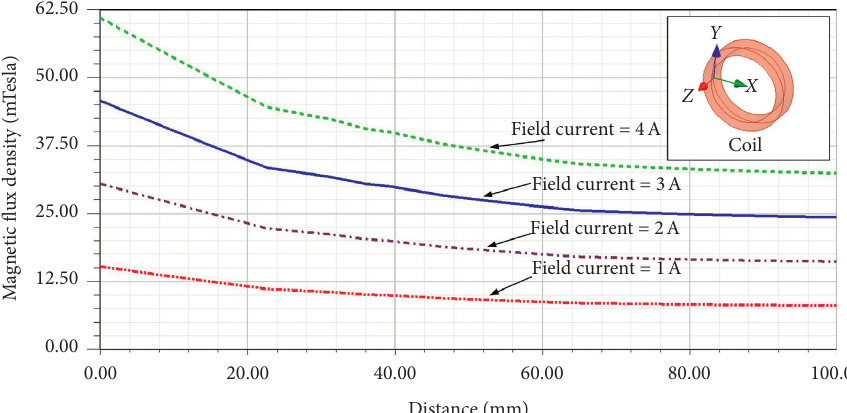
Figure 14: Magnetic flux density curves with different field current and position coordinate of